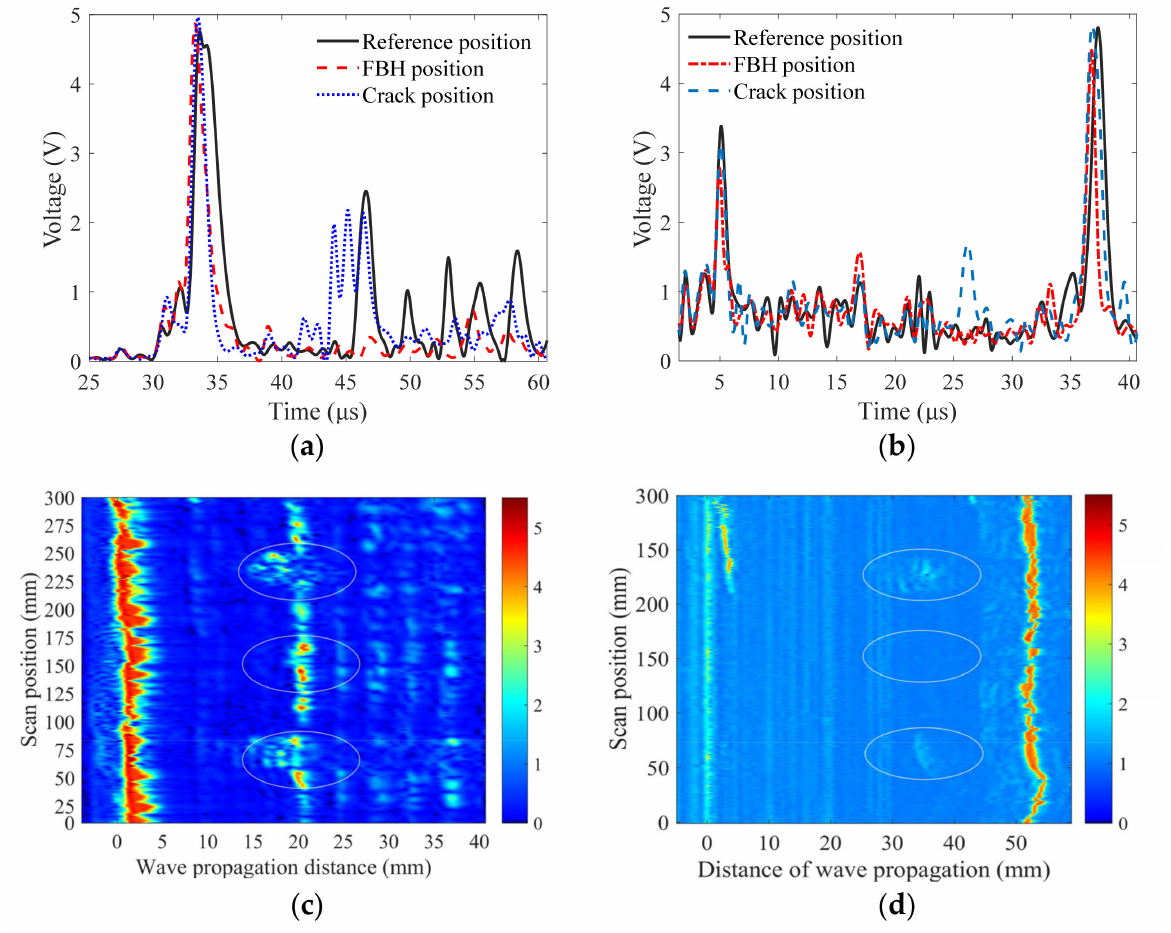
Figure 12. Weld inspection results. ( a ) A-wave signals and ( c ) B-image determined using a PIP transducer. ( b ) A-wave signals and ( d ) B-image determined using a contact shear wave